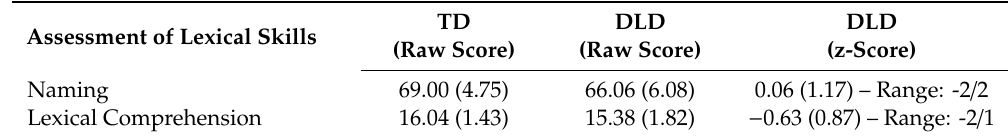
Table 5. Results (means and SDs) of the assessment of naming and lexical comprehension skills in the two groups of participants. For children with DLDs, both raw scores and z-scores with respect to normative data are reported in separate columns. For z-scores, ranges are also reported. The asterisk (*) shows when the group-related di ff erence in raw scores is